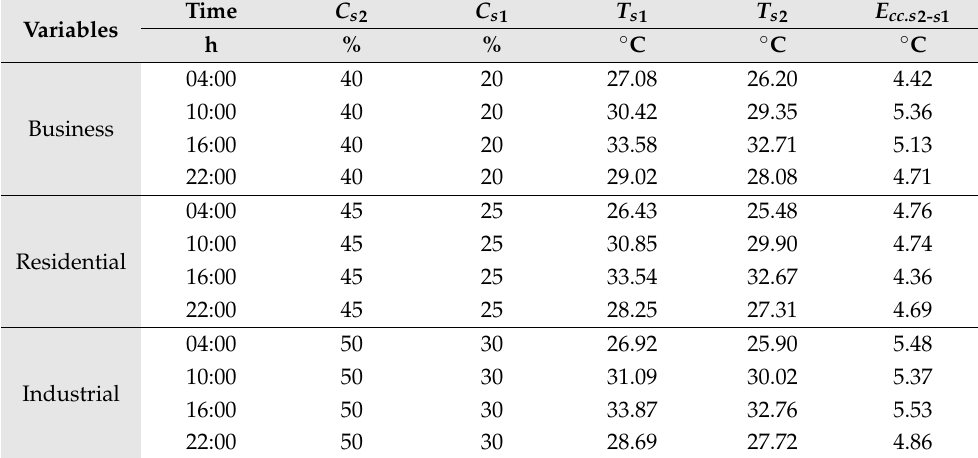
Table 4. E cc of four times in different